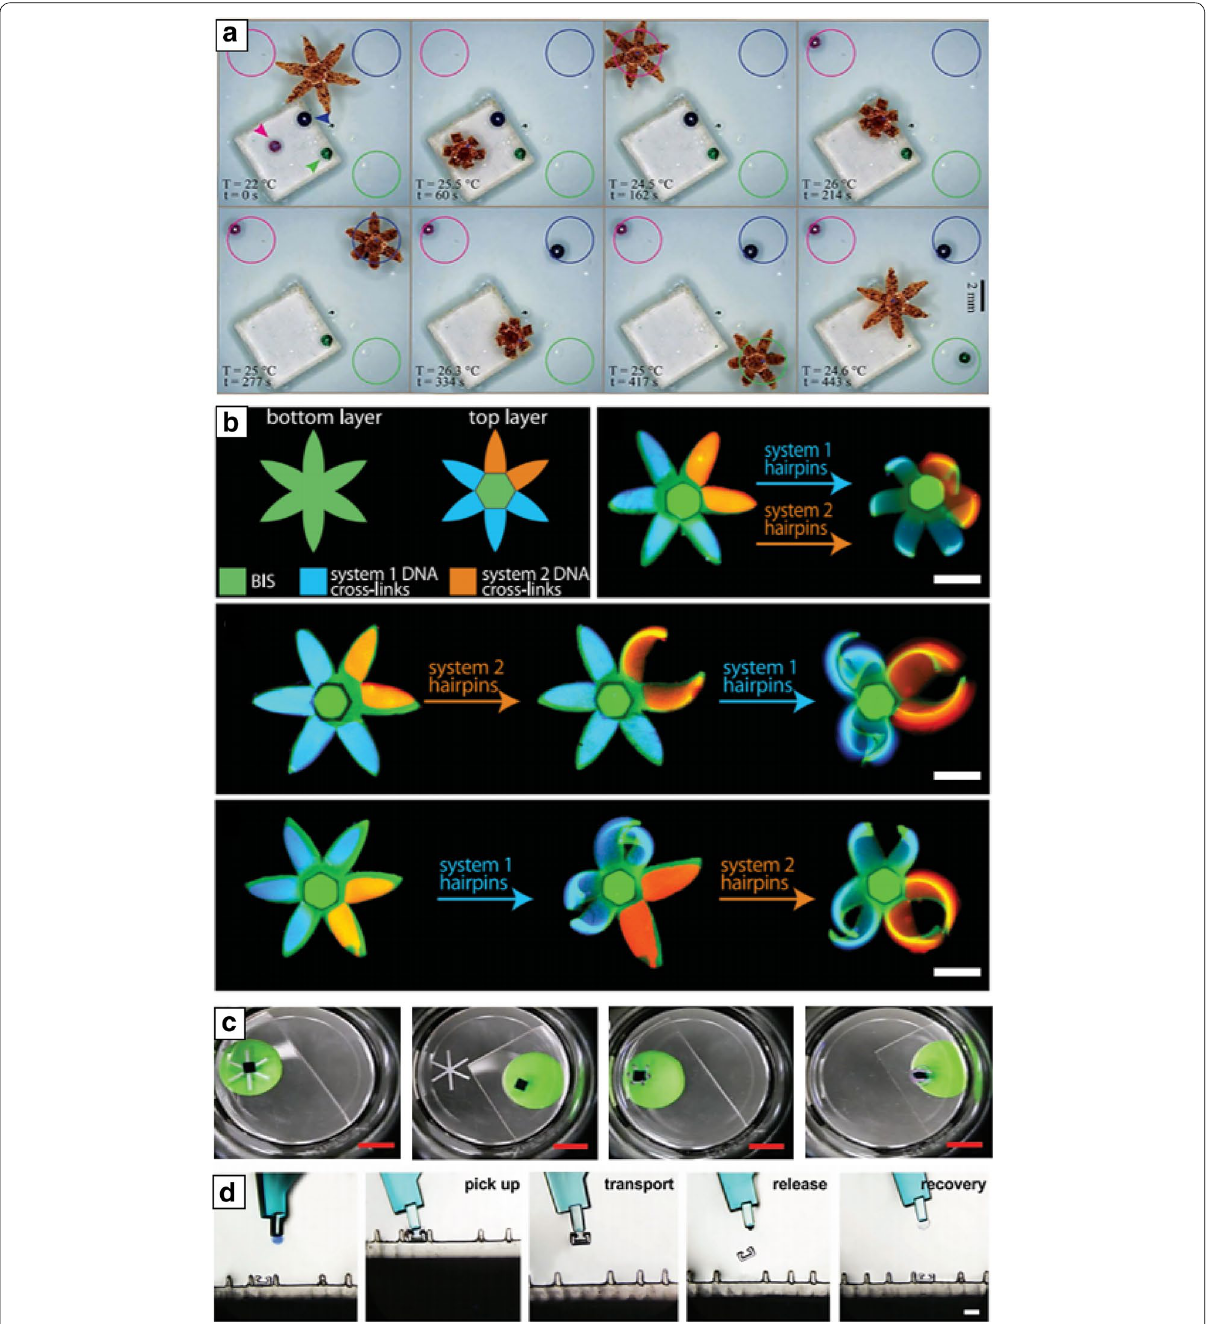
Fig. 6 Untethered soft grippers as smart actuators or manipulators. a Thermomagnetically responsive untethered soft gripper that detects and sorts differently colored beads in the respectively colored drop areas autonomously (reproduced with permission [57]. Adapted with permission under the terms of the Creative Commons Attribution Non Commercial License 4.0 license. Copyright 2017, The Authors). b Shape programmable DNA-crosslinked untethered soft gripper that presents shape morphing in response to external programmed DNA hairpin sequences (reproduced with permission [102]. Copyright 2017, AAAS). c Bifurcation mismatch strain driven shape transformation of stimuli responsive soft gripper that has no hinges in a thin bilayer structure (reproduced with permission [8]. Copyright 2018, Wiley–VCH). d Demonstration of the universal pick up, transport, release, and recovery process of a soft robotic microgripper (reproduced with permission [21]. Copyright 2018,